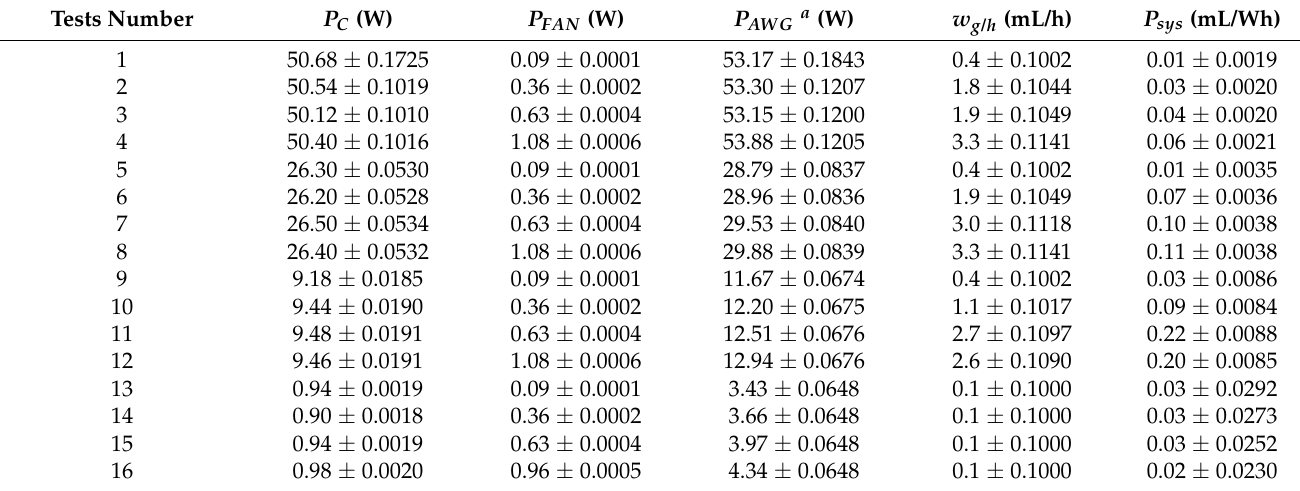
Table 3. FoMs of the Portable Atmospheric Water Generator (PAWG) results under the parametric tuning.